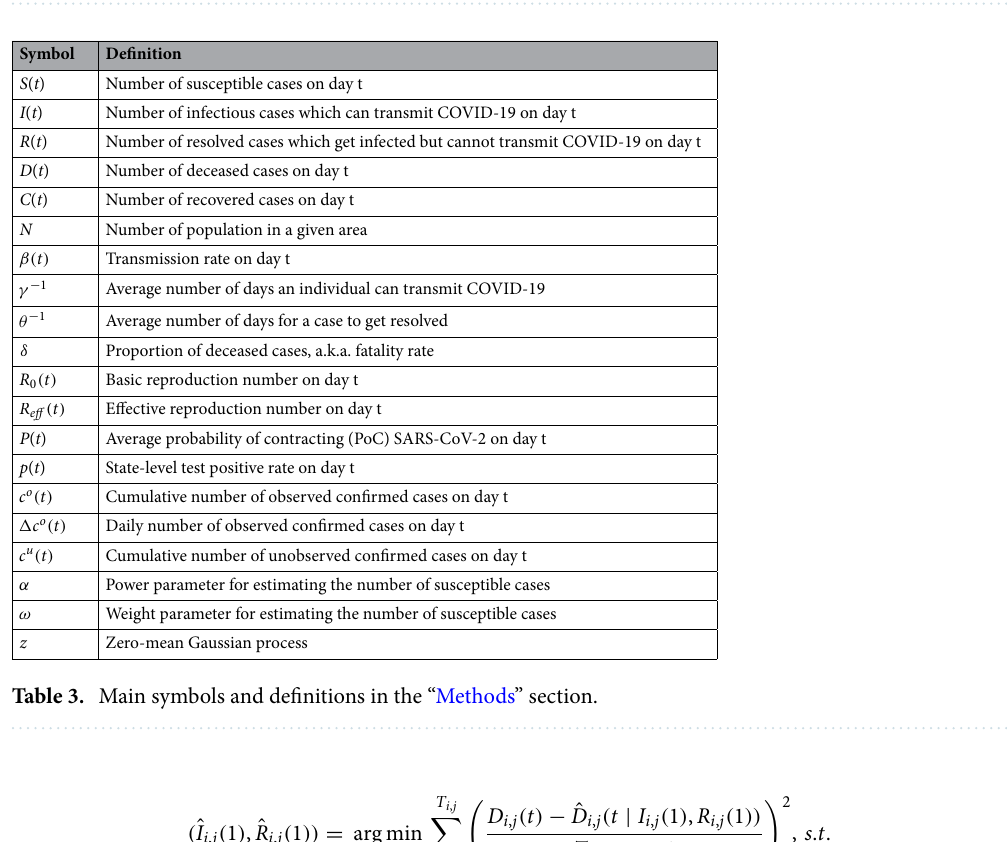
Figure 13. ( a ) The 7-day averaged daily confirmed cases in the US from 21 March 2020 to 20 September 2020. ( b ) the 7-day averaged test positive rate in the US from 21 March 2020 to 20 September 2020.